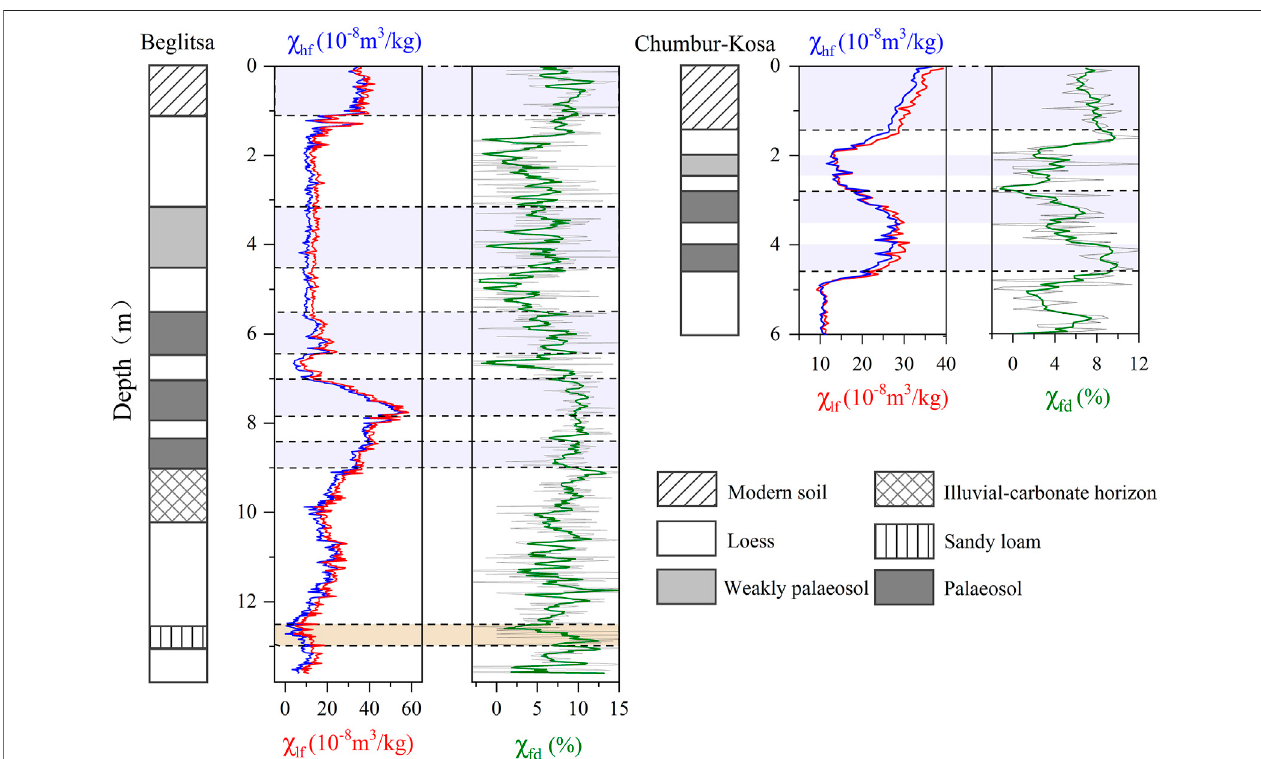
FIGURE 2 | Magnetic susceptibility(MS) variations in the Beglitsa and Chumbur-Kosa sections. The blue line represents χ hf , the red line denotes χ lf , and the green line is indicative of χ fd %, respectively (the χ fd % data have been smoothed by fi ve points using adjacent-averaging method).